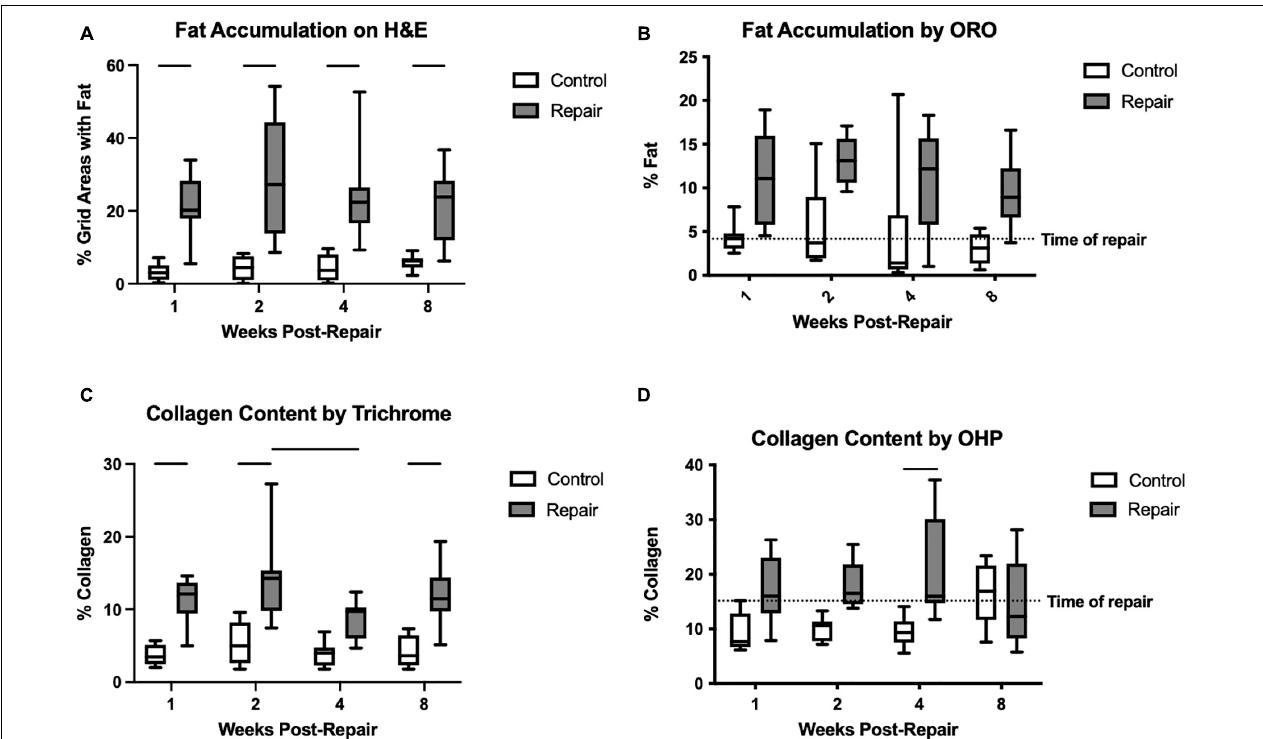
FIGURE 3 | Fat accumulation was significantly increased on the repair side compared to control for every timepoint on H&E staining (A) . Similarly, for ORO, the main effect of treatment was significant but pairwise comparisons were not (B) . Collagen content as a marker of fibrosis was increased after repair as well on trichrome staining (C) and hydroxyproline assay (D) . Data presented as mean ± SD for bar graph, or minimum and maximum for box plot, N = 8 per timepoint. Significant comparisons ( p < 0.05) within timepoint or within treatment group are indicated by horizontal line. Dotted line represents historical control data from previous study (Vargas-Vila et al., 2021) at 8 weeks after tenotomy (time of